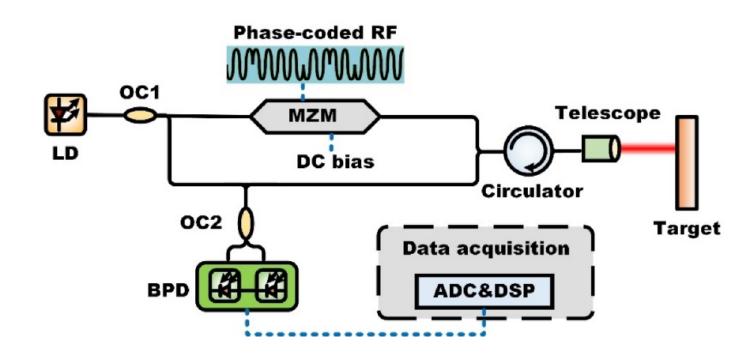
Figure 4. Schematic configuration of the proposed coherent RAMCW LiDAR. LD: laser diode, OC: optical coupler, MZM: Mach-Zehnder modulator, BPD: balanced photodetector, ADC: analog-to- digital converter, DSP: digital signal processor.